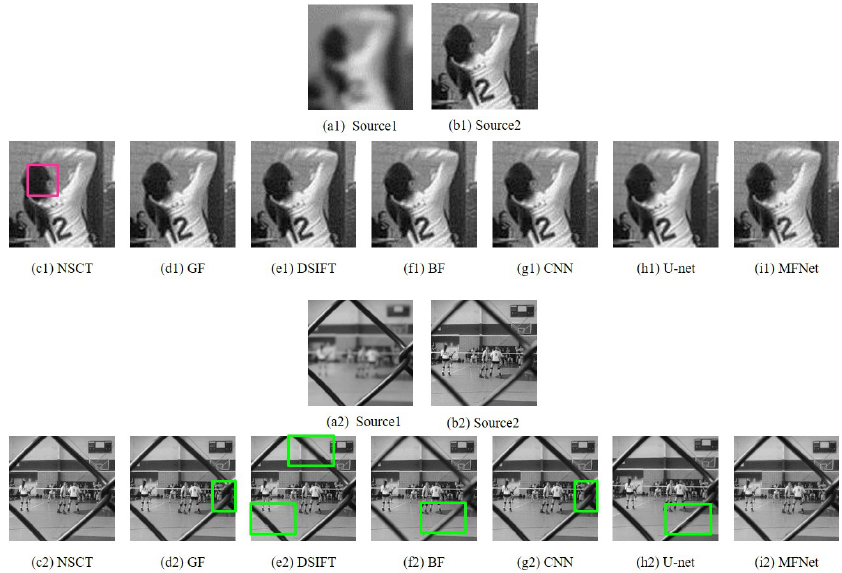
Figure 6. Magnified regions of the “Volleyball Court” source images and fused images obtained with different